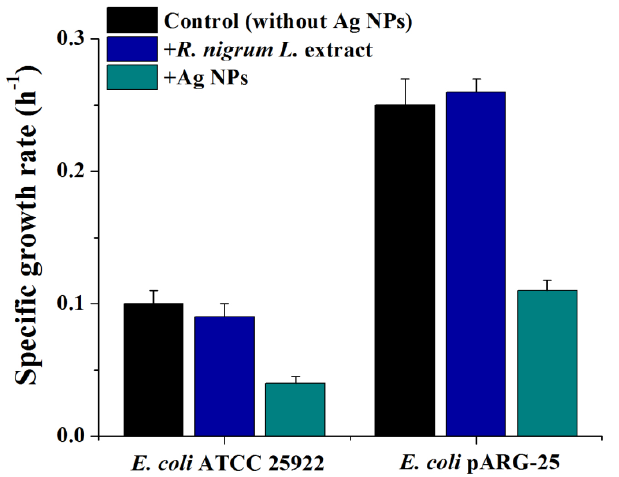
Figure 5. Impact of biogenic Ag NPs on specific growth rate of E. coli ATCC 25922 and kanamycin- resistant E. coli pARG-25 strains.